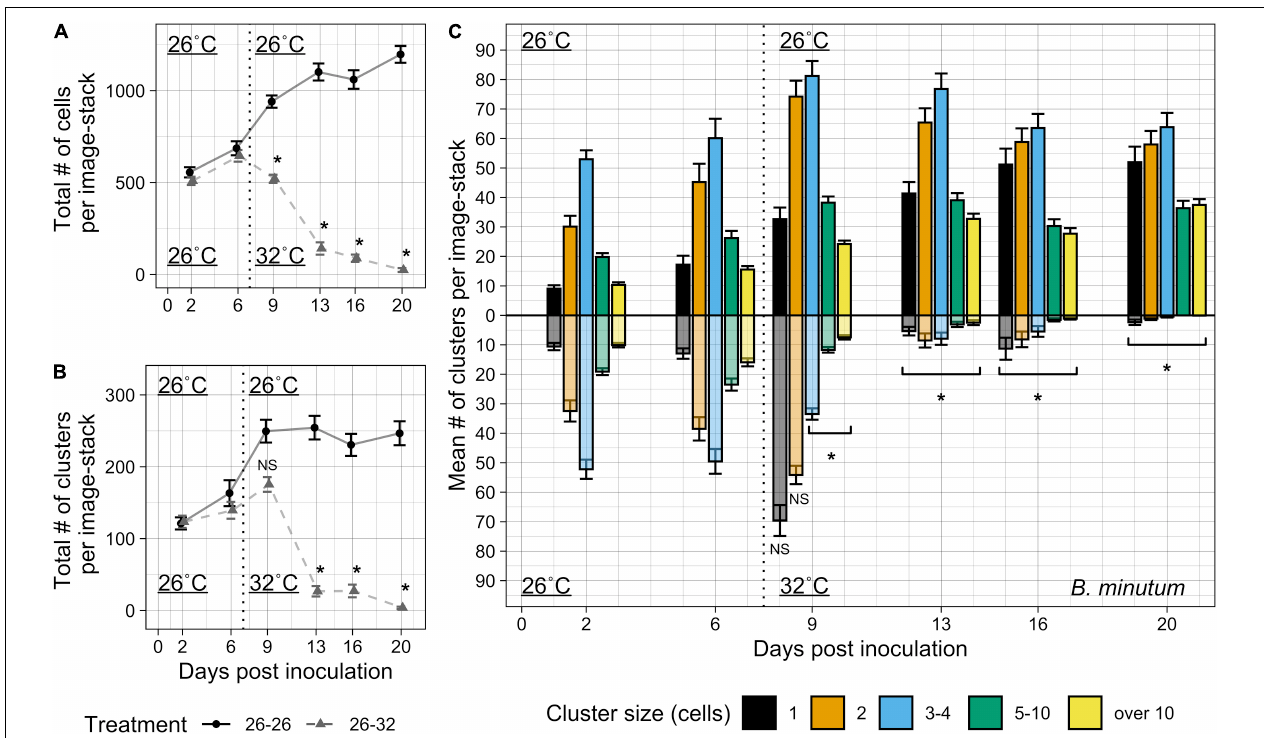
FIGURE 3 | Colonization by B. minutum over 3 weeks at 26 and 32 ◦ C. Algal symbiont populations were monitored over 3 weeks in the tentacles of Aiptasia polyps under ambient and elevated temperature regimes. (A) The total numbers of cells per sample image-stack were measured over a 3-week period (3 sample image-stacks per anemone, 24 anemones per treatment). During the first week both treatments received the same 26 ◦ C temperature treatment to promote colonization. After 7 days, one treatment remained at 26 ◦ C and the other treatment was moved to 32 ◦ C to compare colonization and bleaching phenotypes. (B) The total numbers of clusters per sample image-stack were measured over 3 weeks under ambient and bleaching conditions. (C) The mean number of cell clusters per image-stack were binned into discrete cell cluster sizes measured over 3 weeks. 26 ◦ C treatment for 3 weeks is shown on the positive y -axis, while 26–32 ◦ C treatment is shown on the negative y -axis, reflected across the x -axis for comparison. The beginning of the difference in treatment conditions is indicated by a vertical dotted line at 7 days post-inoculation. Aiptasia were inoculated with a concentration of 5 × 10 4 cells • mL − 1 . Error bars signify standard error for the total abundance of clusters or cells. Asterisks indicate significant differences between temperature treatments at each timepoint by Tukey post hoc tests ( p < 0.01 in all